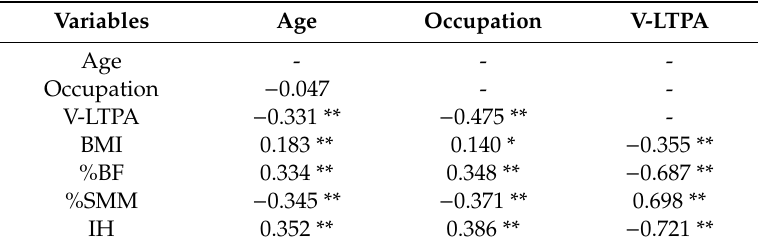
Table 2. Correlation analysis.